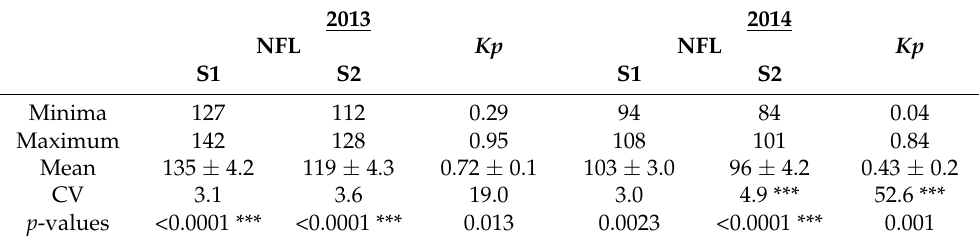
Table 4. Mean values plus/minus standard error of days to appearance of flag leaf ligule and photoperiod sensitivity index for 55 Chadian dry-season sorghum accessions, under early and late sowing dates in 2013 and 2014, at the You é research farms in Chad.